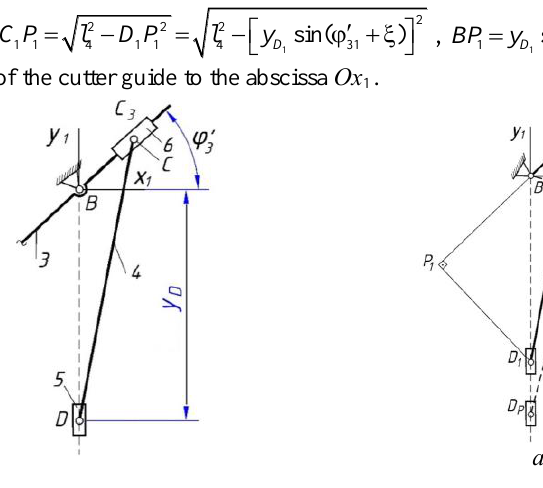
Fig. 4. Structureal scheme of the combined mechanism with variable lwngth of the conditional crank